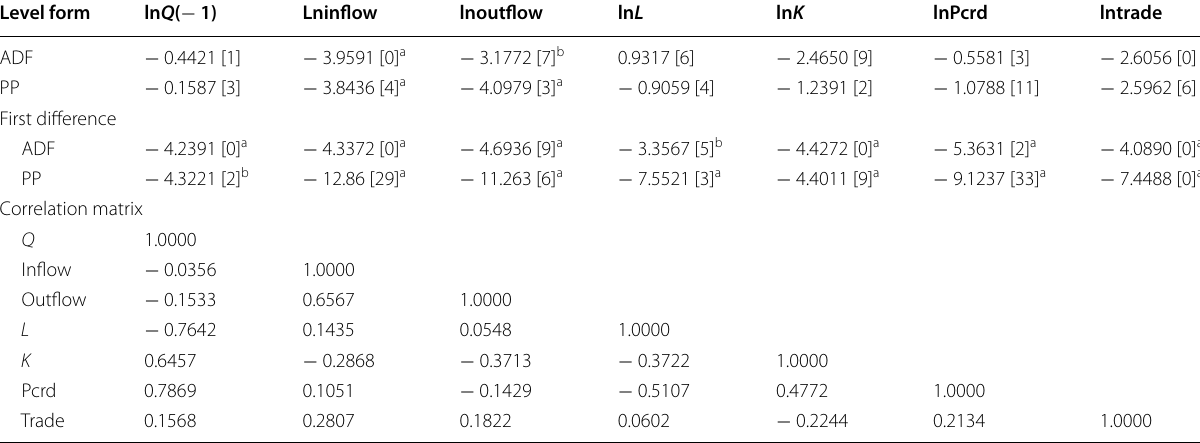
a,b Indicate 1% and 5% level of significance